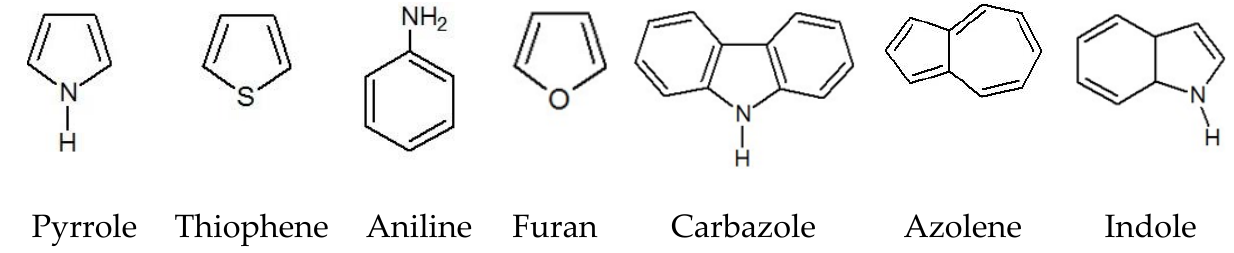
Figure 11. Molecules of heterocyclic aromatic compounds.